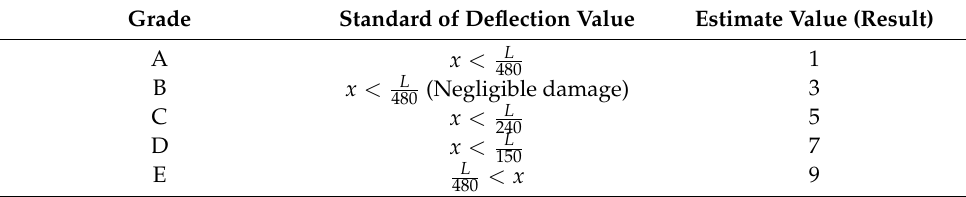
Table 3. Design standard of deflection (KDS 14 20 30).